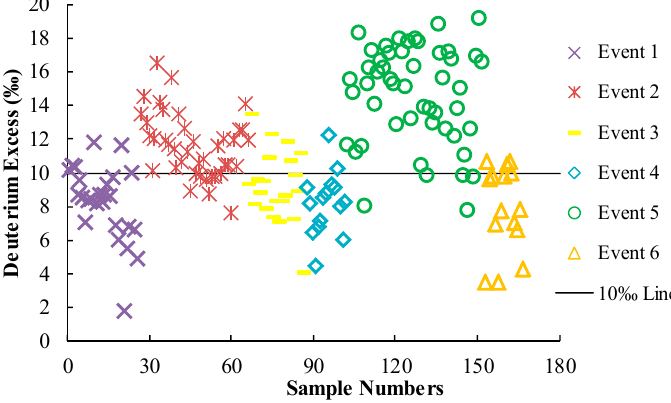
Figure 5. Distribution of deuterium excess in Hemuqiao basin for six rainfall events.